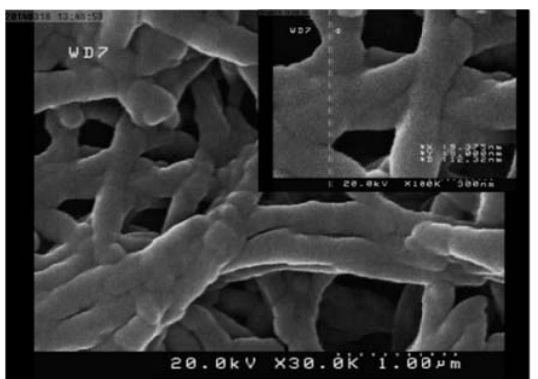
Fig. 2: SEM f 1:1.5 for C